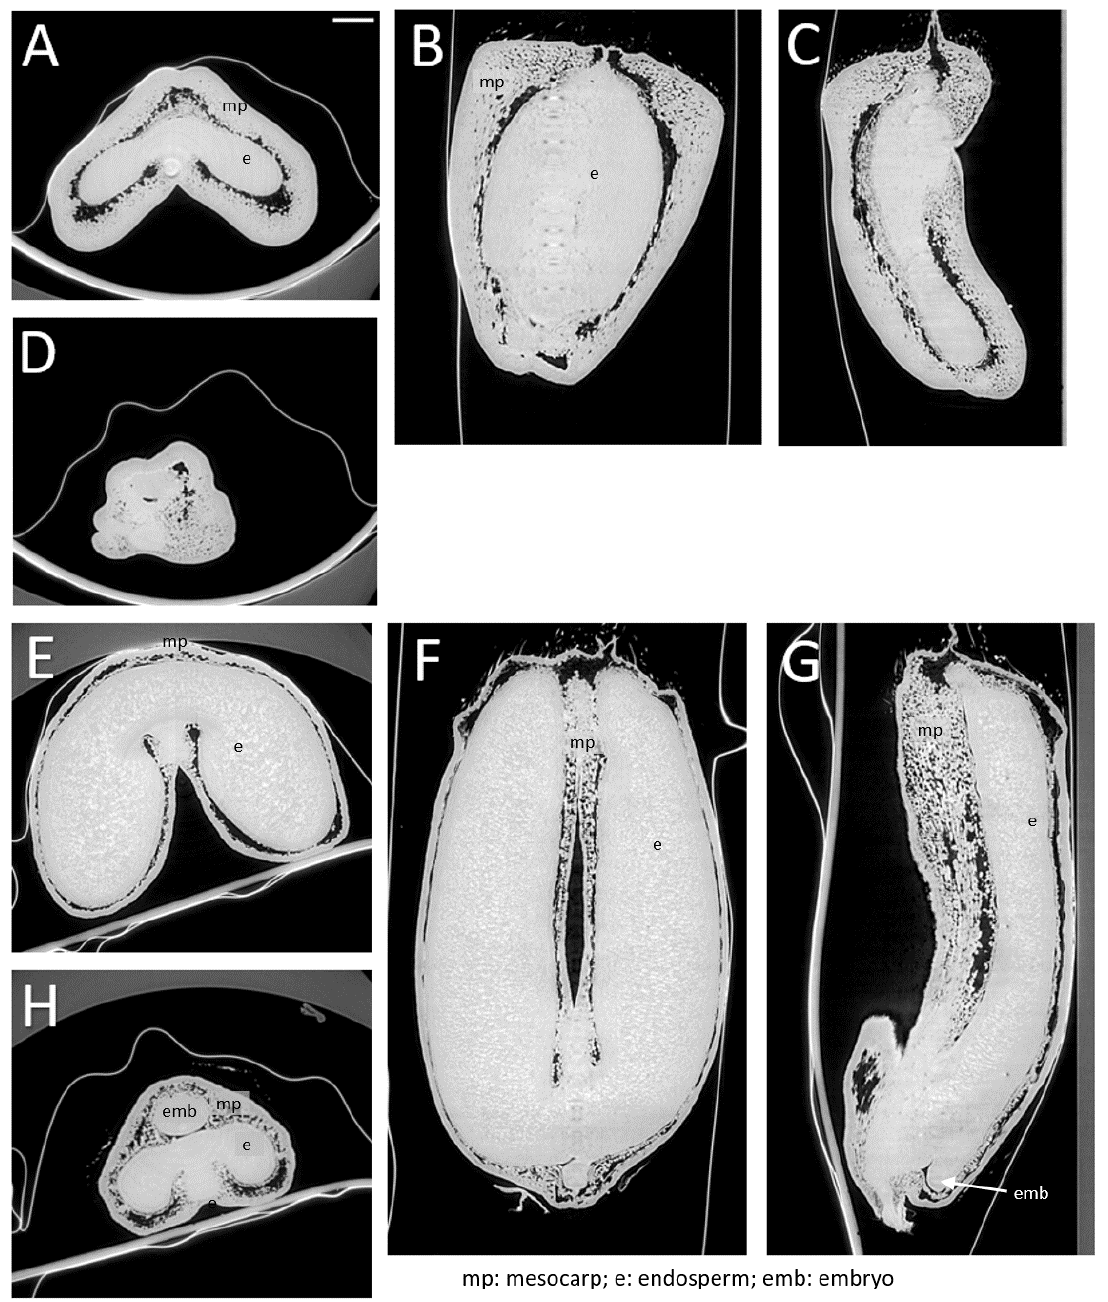
Figure 4. Virtual slices within low-resolution images of whole grains at contrasted development stages. ( A ) XY slice at middle z-position for grain at 100 °DAA. ( B , C ) XZ slice at middle y-position and YZ slice at middle x-position of the same grain. ( D ) XY slice in the bottom of the grain, showing a portion of the embryo. ( E – H ) same representations for a grain at 250 °DAA. Scale bar represents 1000 µm.